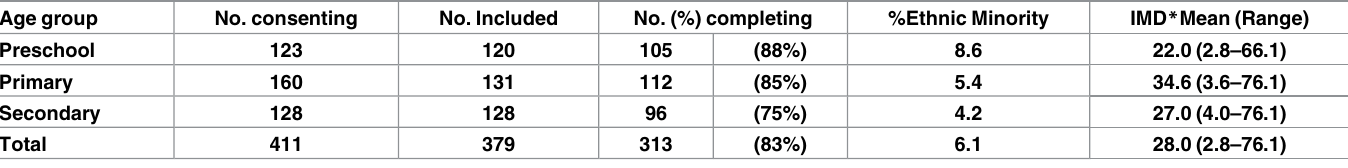
Table 1. Recruitment and demographics of participants completing the study. Age